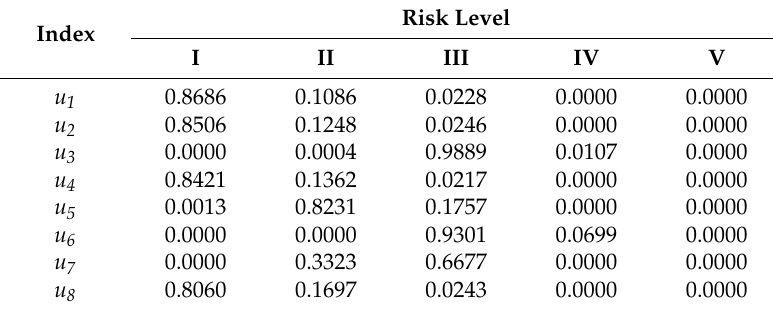
Table 15. Certainty degrees of Bijie City in Guizhou province.